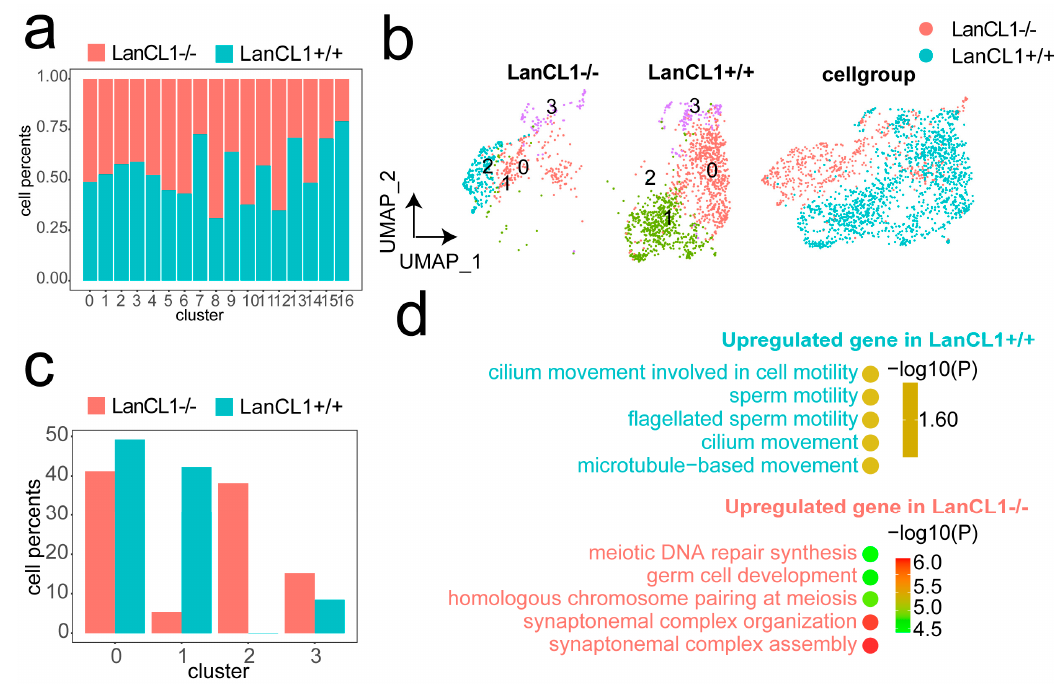
Figure 3. The LanCL1 gene maintains the development of normal sperm motility in germ cells. ( a ) The percent of cell numbers in every cell cluster from LanCL1+/+ and LanCL1 − / − mice. ( b ) UAMP plot of the cluster 7. ( c ) The cell percent of new clusters. ( d ) GO annotation of the DEGs in the LanCL1 − / − and LanCL1+/+ mice.